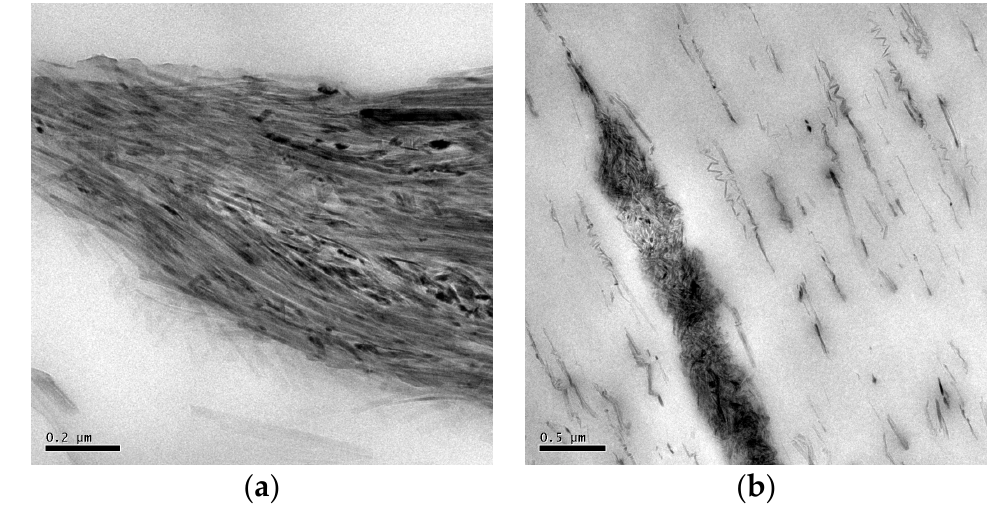
Figure 5. TEM images of large agglomerates found in both ( a ) drawn, and ( b ) undrawn samples of PCL + 2 wt% sep.